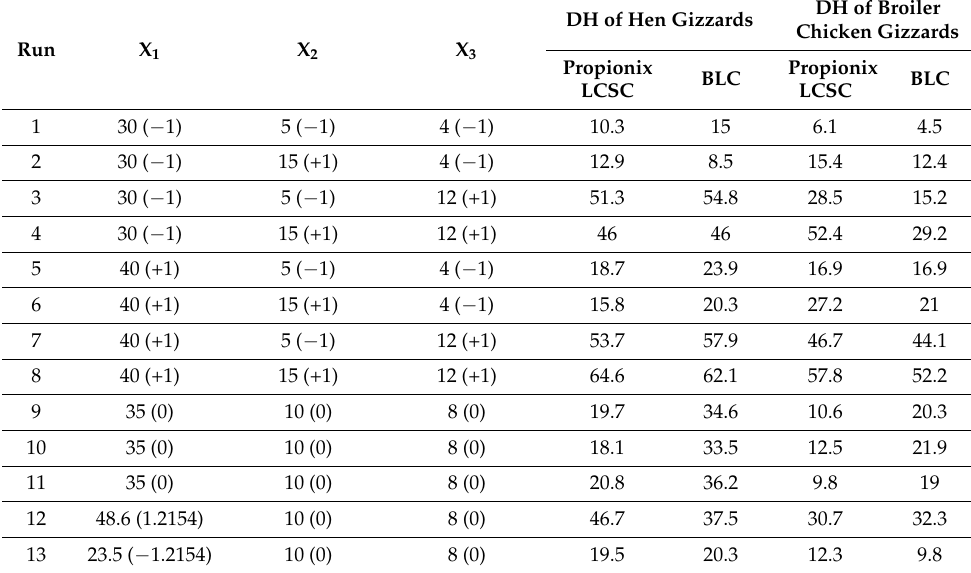
Table 1. Central composite rotatable design matrix showing coded and actual values of process parameters and their effects on the response variable, degree of hydrolysis